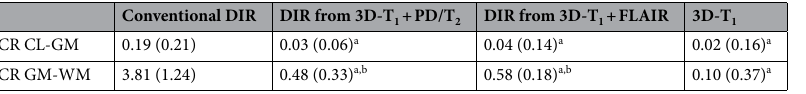
Table 3. Contrast ratios. Data are presented as contrast ratio (CR; ± SD); contrast ratio is defined as (SI 1 –SI 2 )/ SI 2 . CL–GM = cortical lesion to grey matter; GM–WM = grey matter to white matter; a statistically significant